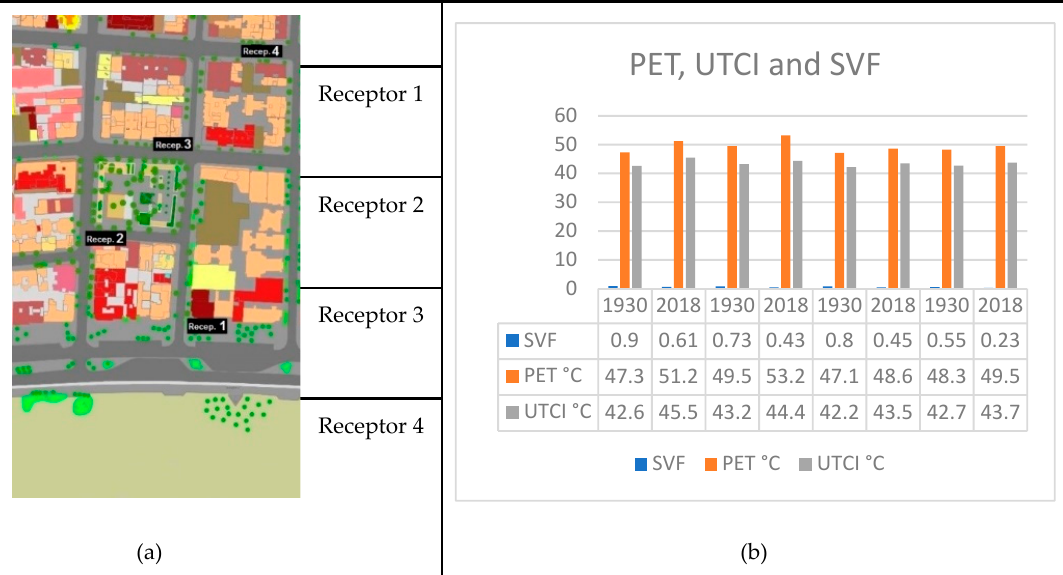
Figure 9. Location of Receptor ( a ) and Results for Physiological Equivalent Temperature (PET), Universal Thermal Climate Index (UTCI), and Sky View Factor (SVF) ( b ).